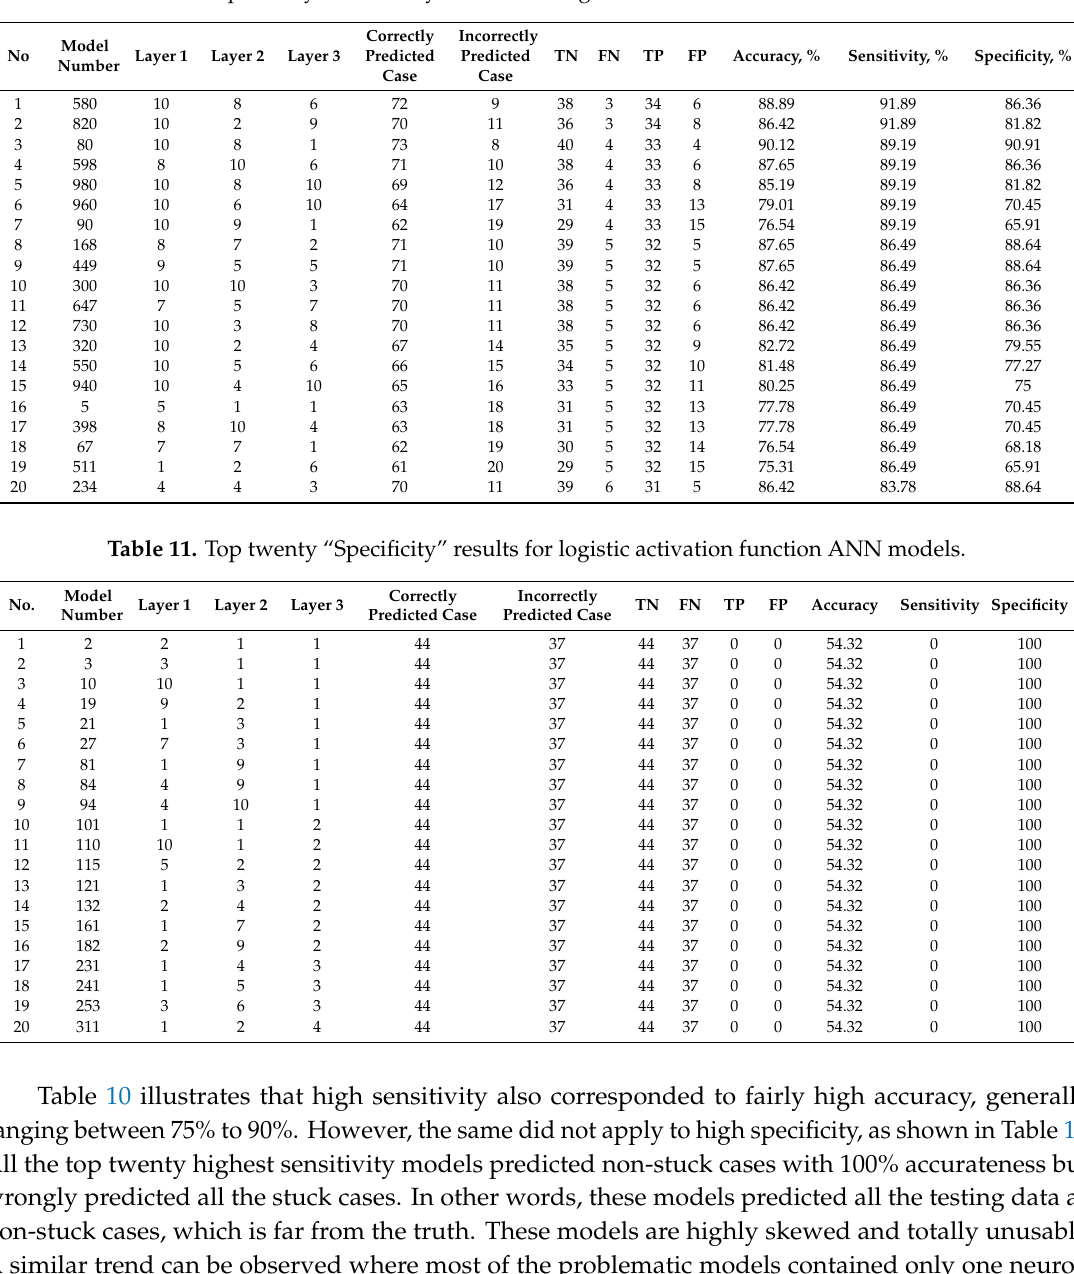
Table 10. Top twenty “Sensitivity” results for logistic activation function ANN models.